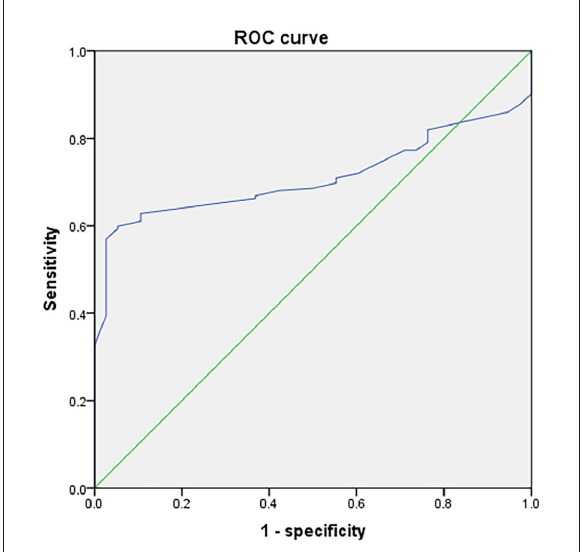
FIGURE2 Receiver operating characteristic (ROC) curve analysis of preoperative measurement values of A β -42 for postoperative neurocognitive dysfunction